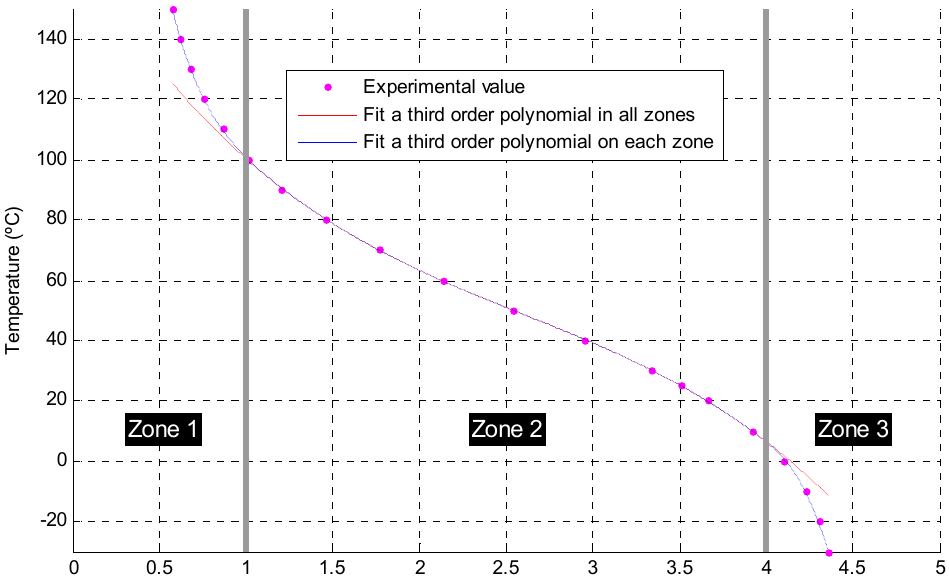
Figure 9. Temperature vs. Output voltage after signal